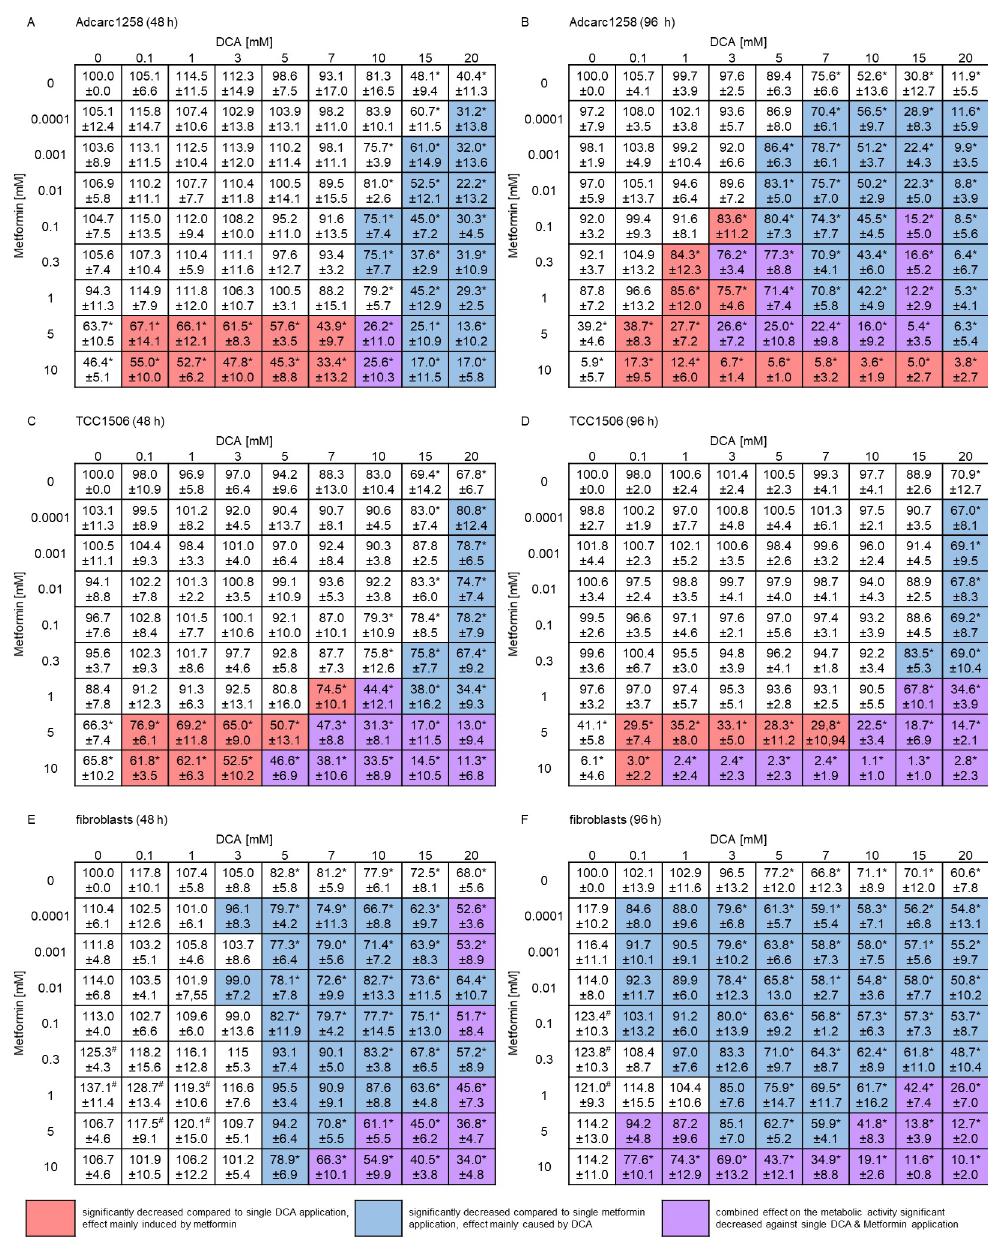
Fig 3. Influence of DCA, metformin or the combination of both agents on the metabolic activity of Adcarc1258 (A and B), TCC1506 (C and D), and fibroblasts (E and F) over 48 h (A, C, and E) and 96 h (B, D, and F). Effect on the metabolic activity of various concentrations of DCA (first row from above), and metformin (first left-hand column) in single application, and both agents combined (all columns and rows dose intersections). All values are expressed as percentage of the metabolic activity of untreated control cells (top left cell). Pink cells: significant difference between the respective DCA single application and the combined treatment (DCA + metformin). Blue cells: significant difference between the respective metformin single application and the combined treatment (DCA + metformin). Purple cells: significant difference between both respective single agent applications and the combined treatment (DCA+ metformin). Asterisk: significantly decreased metabolic activity compared to the untreated control and the treated samples. Number signs: significantly increased metabolic activity compared to the untreated control and the treated samples. Data are displayed as mean and standard deviation. Significance is set at p <